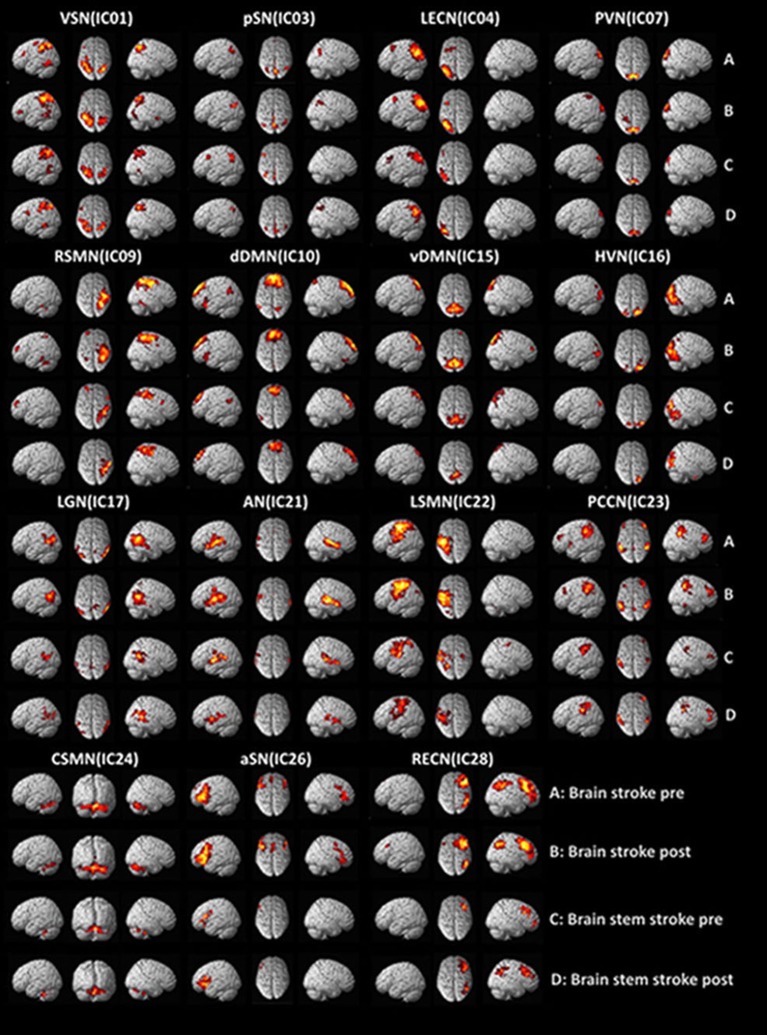
Functional MRI findings in stroke patients with dysphagia before and after swallowing training. VSN, visuospatial network; pSN, posterior salience network; LECN, left executive control network; PVN, primary visual network; RSMN, right sensorimotor network; dDMN, dorsal default mode network; vDMN, ventral default mode network; HVN, high visual network; LGN, language network; AN, auditory network; LSMN, left sensorimotor network; PCCN, precuneus network; CSMN, cerebellar sensorimotor network; aSN, anterior salience network; RECN, right executive control network.